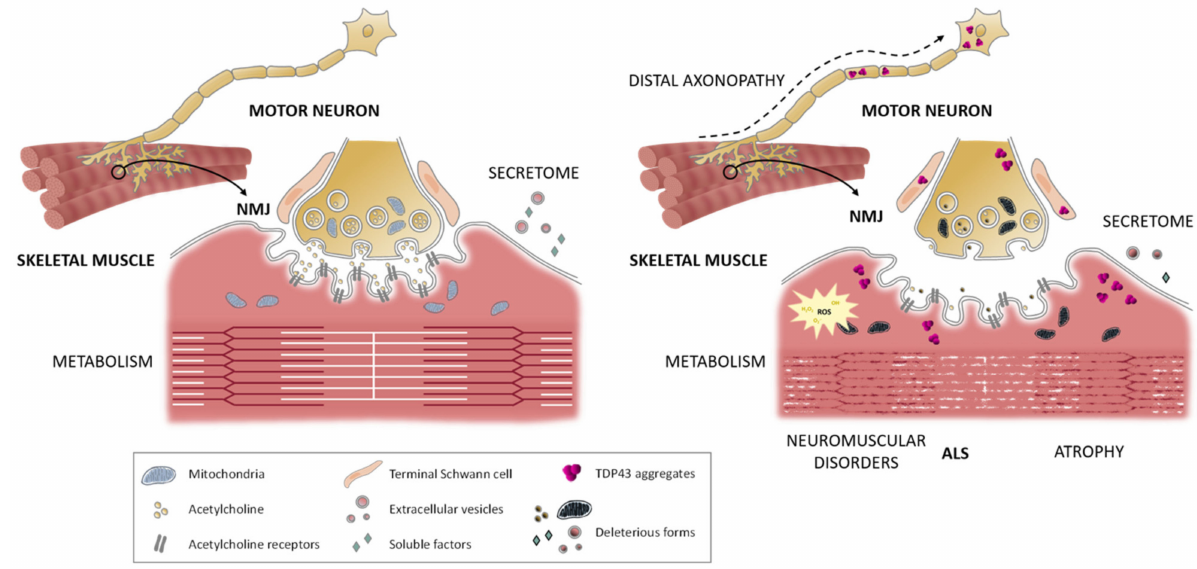
Figure 1. Proposed model for the skeletal muscle as a key contributor on ALS peripheral etiopathogenesis through a “dying back” mechanism. The main components of the neuromuscular junction (NMJ) are depicted for healthy (left) and ALS (right) states, respectively: the pre-synaptic part (nerve terminal), post-synaptic part (motor endplate), and the synaptic cleft in between the two. As illustrated, NMJs in ALS are destabilized, and different components are altered. Indeed, early metabolic and myogenic defects in skeletal muscle trigger mitochondrial dysfunction, oxidative stress, and increased production of reactive oxygen species (ROS). Besides, dysregulated protein homeostasis enhances the presence of cytoplasmic and nuclear aggregates, including TDP-43 inclusions in muscle, that are also present in other cell types, including terminal Schwann cells and motor neurons (MN). Moreover, the skeletal muscle increases extracellular vesicles production (secretome), which may content toxicity and release it to other NMJ cell components. All these muscle alterations result in muscle atrophy and NMJ dismantlement, which are classical hallmarks of ALS. Thereby, altered intercellular communication exacerbates nerve retraction and degeneration of the distal MN ending, which is spread in a retrograde manner (dashed black arrow) into the soma, resulting in progressive MN